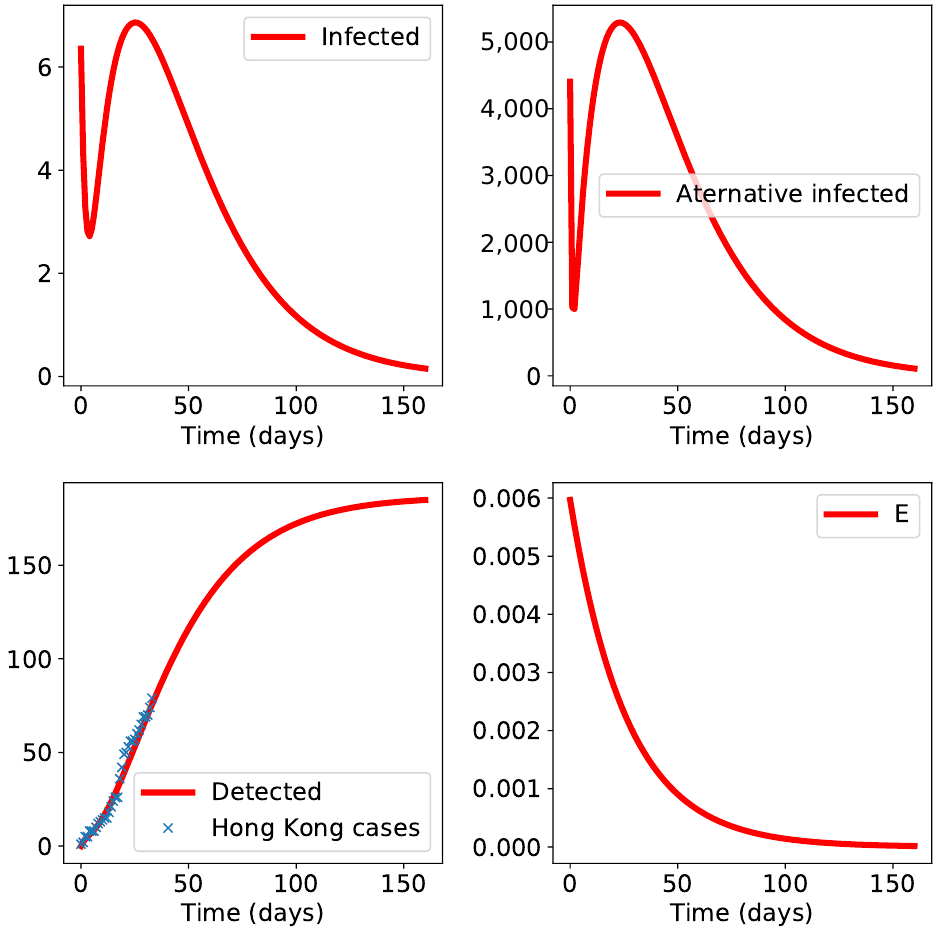
Figure 4. Simulation results for Hong Kong. The initial time t 0 is set to 22nd January. The class “E” is small and decreasing, which indicates negligible environmental